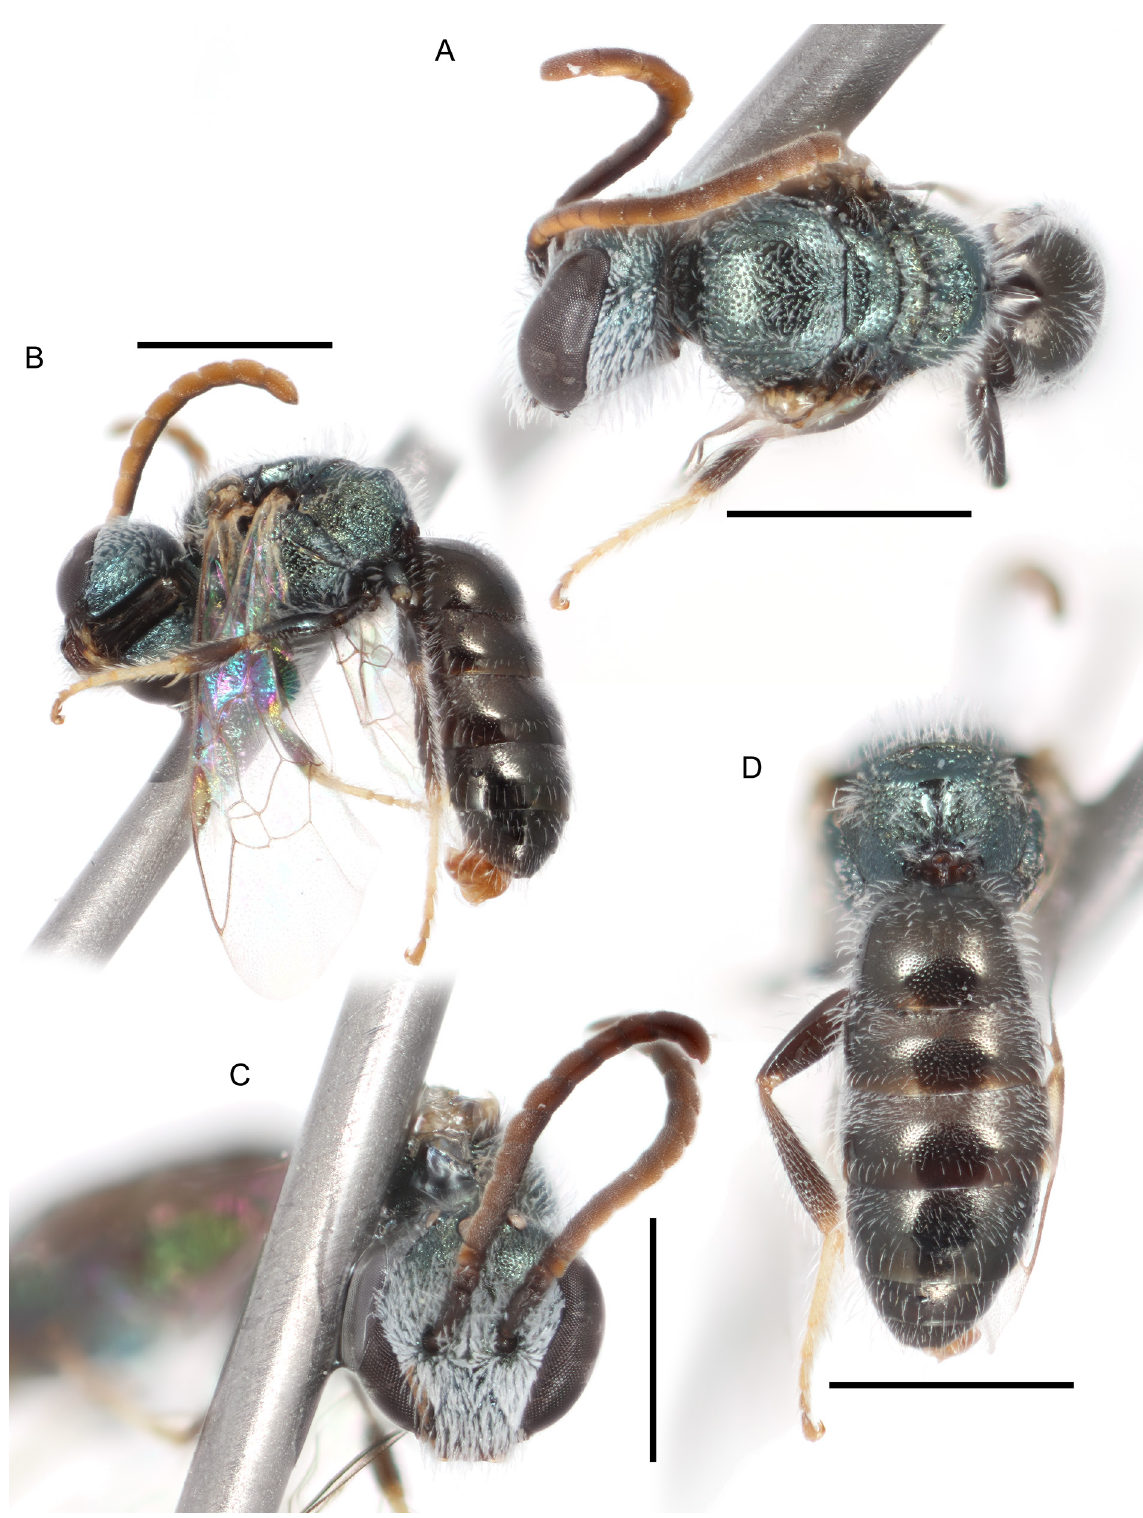
Fig. 29. Lasioglossum ( D. ) clematisellum (Cockerell, 1904), ♂. A . Dorsal habitus. B . Lateral habitus. C . Face. D . Propodeum and metasoma. Scale bars: 1